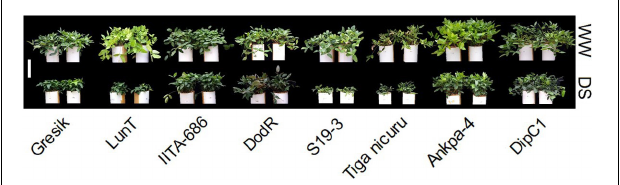
FIGURE 2 | Differential plant shoot sizes at final harvest: 105 days after emergence (DAE; 50 days of DS recovery) of eight bambara groundnut genotypes grown in soil-filled PVC columns in a rainout shelter under WW and DS (at 50 days of recovery) in 2019. White bar = 30 cm.